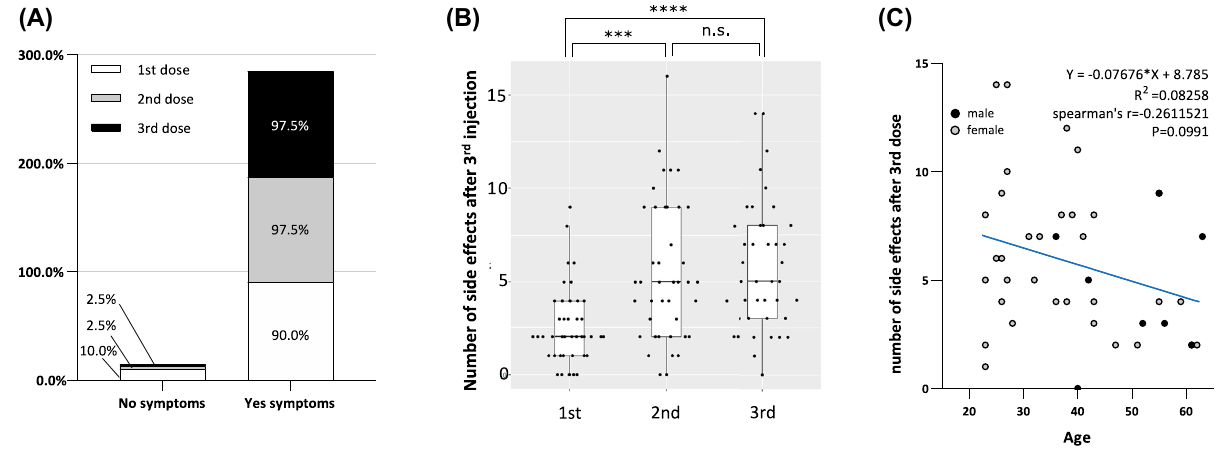
Figure 2: Summary of the side effects of the BNT162b2 vaccine. (A) Percentages for the presence (symptoms) or absence (no symptoms) of the side effects of the BNT162b2 vaccine reported by the participants after the first (white columns), second (gray columns) and third (black columns) doses of the vaccine. The results for first and second vaccinations [4] were shown, as a comparison. (B) Box plots of total numbers of side effects in individual participants after the fi rst, second and third doses. The results for fi rst and second vaccinations [4] were shown, as a comparison. ***p<0.001, ****p<0.0001, n. s., not signi fi cant.(C)Correlationofageandthenumberofsideeffectsaftertheinjectionwithsuperimposedthelinearregressionlines(with95%CI). ThestatisticalmethodsofSpearman ’ srankcorrelationcoef fi cientwereused.Nosigni fi canceswereobserved.Blackcirclesshowmales,while gray circles show females. Linear regression lines,